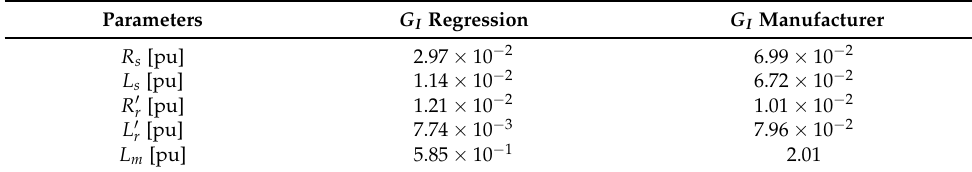
Table 3. Induction Generator